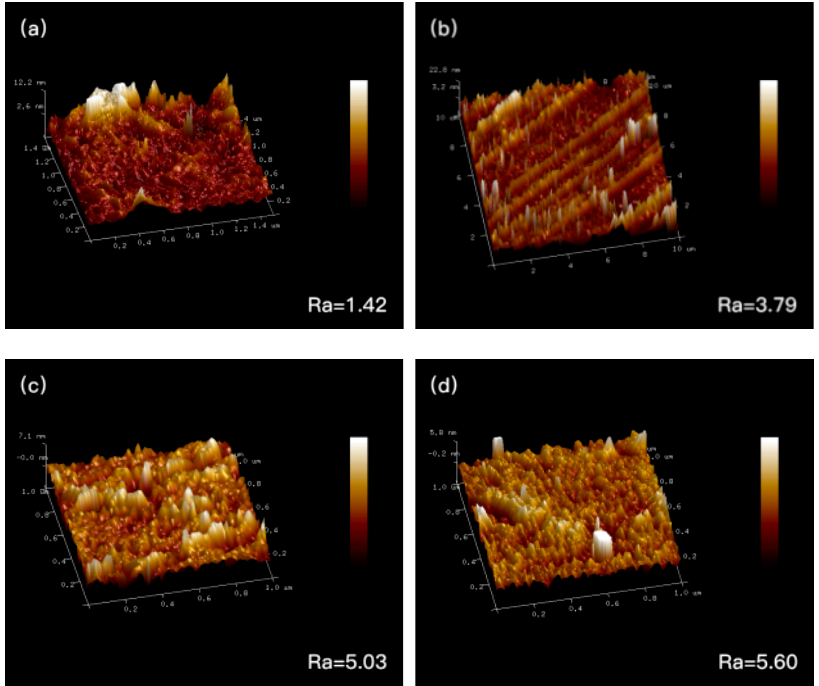
Figure 7. AFM micrograph of the blend films ( a ) S0 film, ( b ) S1 film, ( c ) S2 film, ( d ) S3 film.